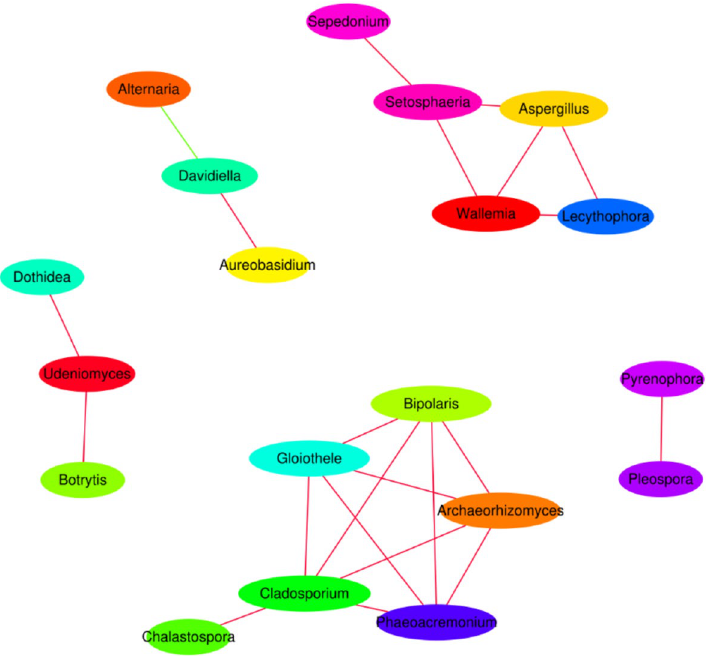
Figure 3. Network analyses at the genus level according to the abundance of fungal pathogens on the surface of Bayou 13 grains from 10 ecological regions. Network analyses of Spearman correlation coefficients reveal the cooccurrence patterns among genera. Different colors represent different genera. Edges (lines) between nodes are colored red for positive correlations between genera and green for negative correlations between genera.